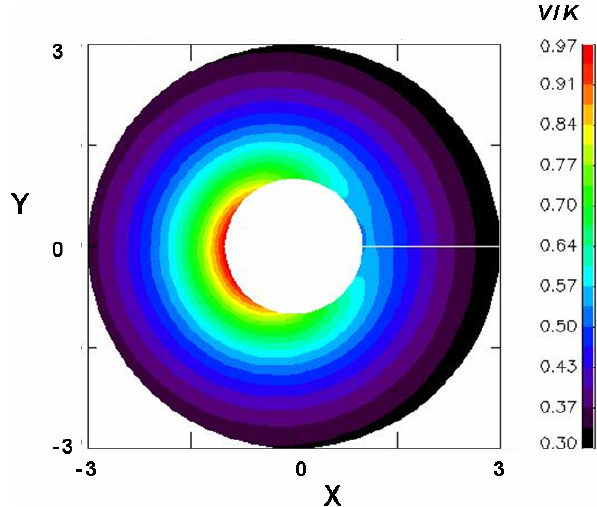
Fig. 11. Normalized potentials for the case R =0.5, α =1.2, φ b =9.3,